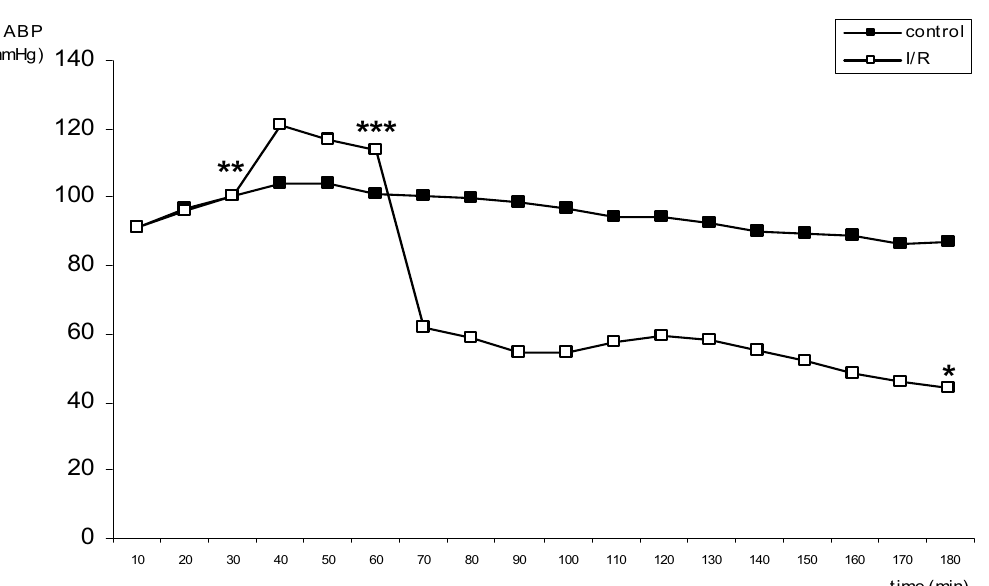
FIGURE 1 – Mean arterial blood pressure (mmHg) along time. Asterisk indicates significant differences according experimental time in I/R group (p <